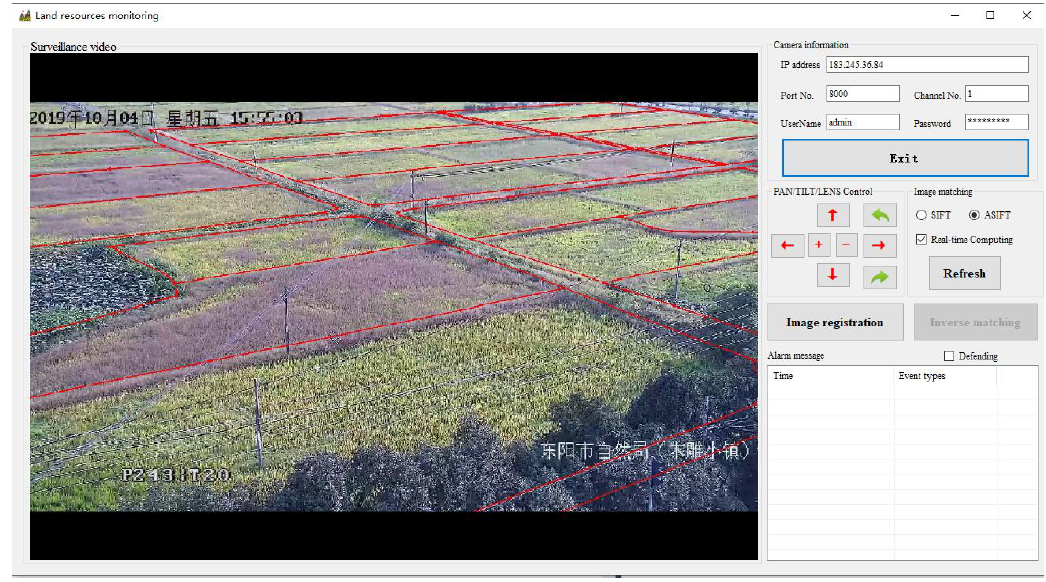
Figure 8. The user interface of video-based surveillance system for cultivated land.